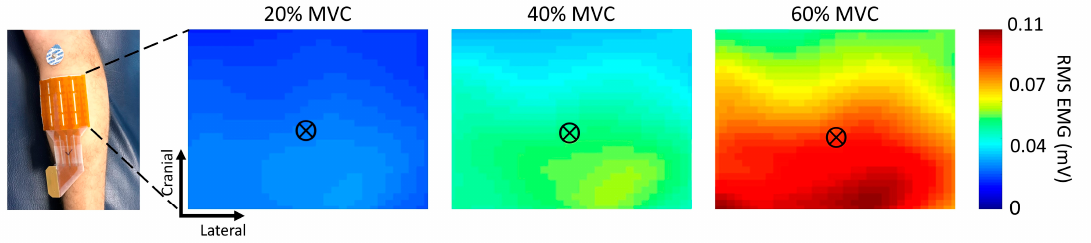
Figure 1. Mean topographic maps of medial gastrocnemius activity at different contraction intensities (N = 12), presented with their respective barycenter. The maps (32 × 28 pixels) were created from the 56 root mean square (RMS) values using an interpolation factor of 4. The reference system at the bottom left corner of the image represents an example of the origin of each image (0,0), from where the barycenter (crossed black circle) coordinates were